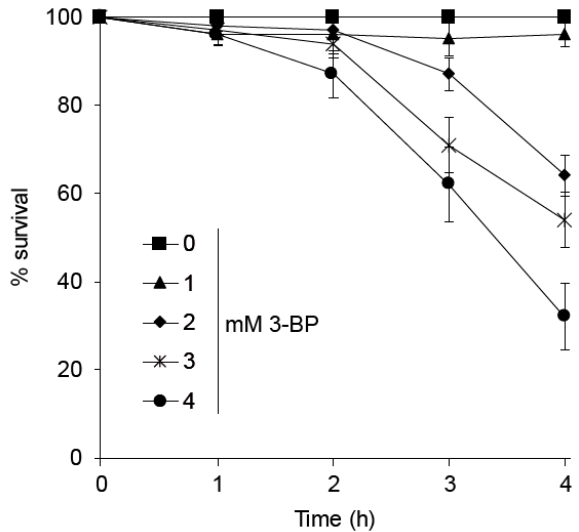
Figure 1. Wild type sensitivity to acute 3-bromopyruvate (3-BP) treatment. Logarithmically growing wild type cells were treated with various 3-BP concentrations for indicated time points. Next, cells were washed and plated on solid SD medium. Survival was calculated as percentage of colony forming units of 3-BP treated cells versus untreated cells. Error bars represent mean value ± standard deviations of mean ( n = 3).